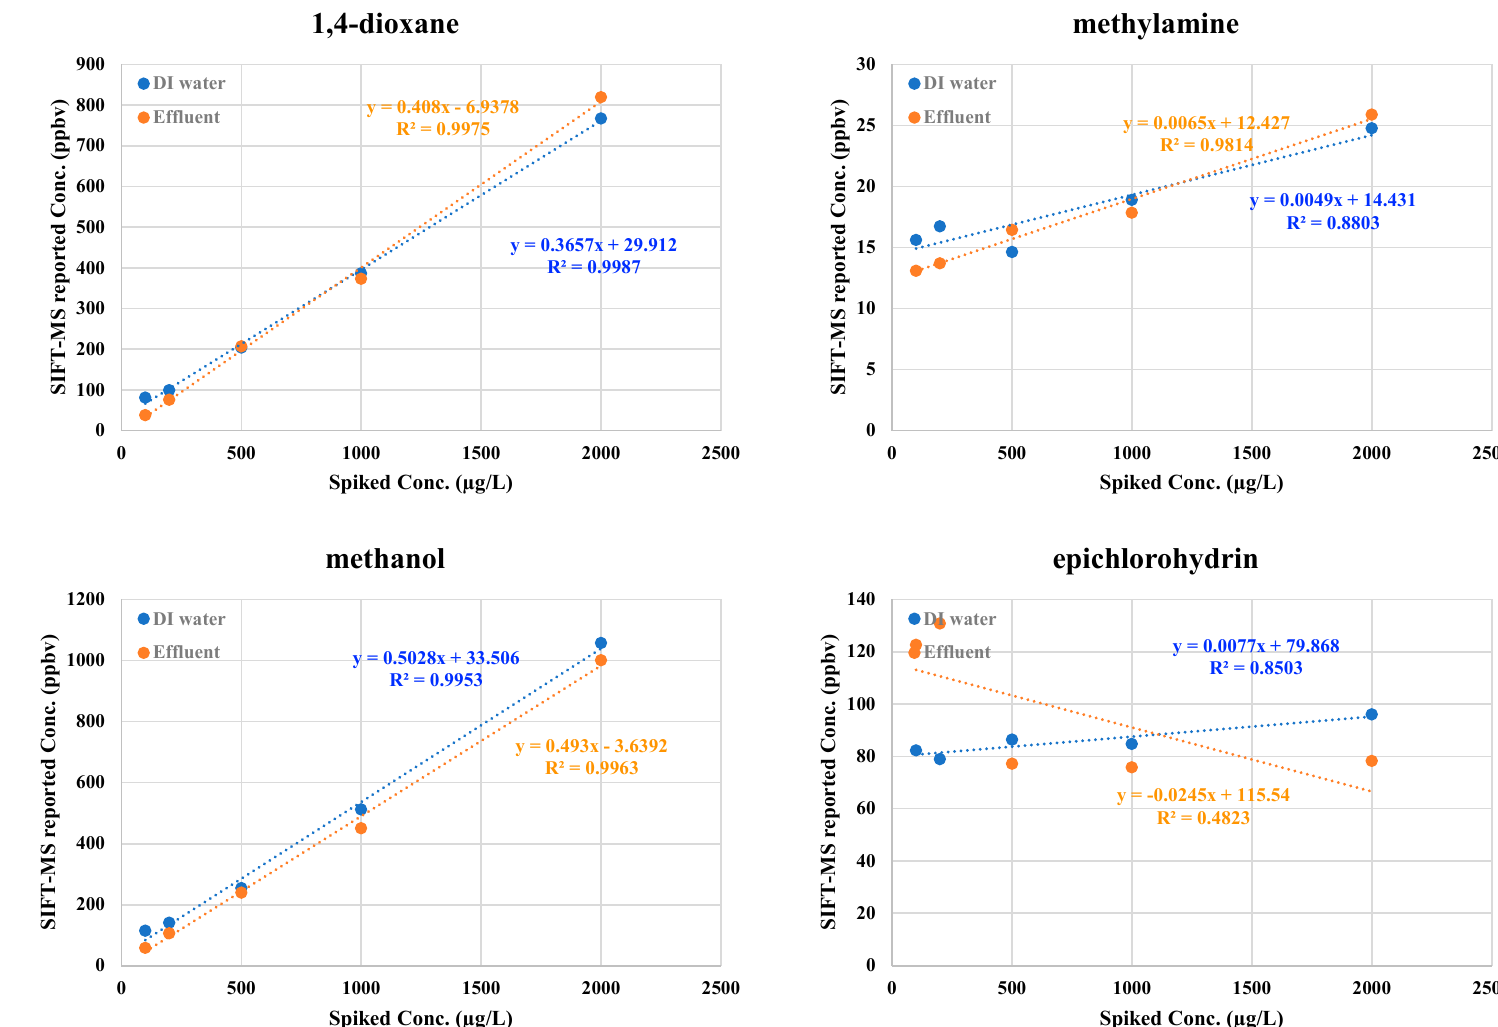
Figure 2. Calibration curves of good (left) and bad (right) linearity under headspace extraction conditions.